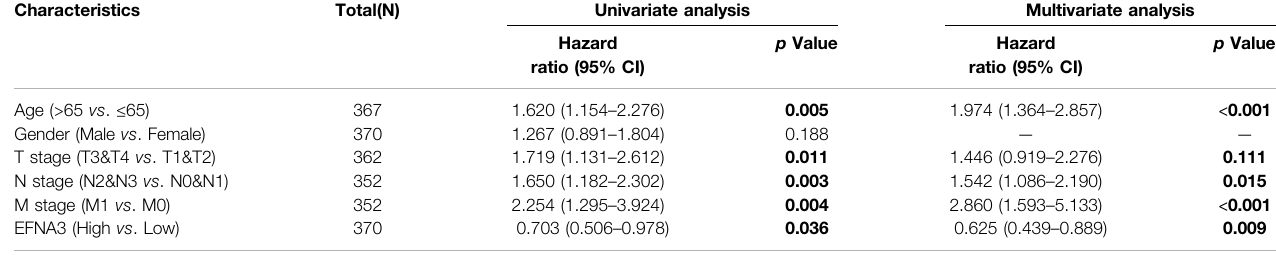
TABLE 2 | Univariate COX regression analysis and Multivariate COX regression analysis for EFNA3. Characteristics